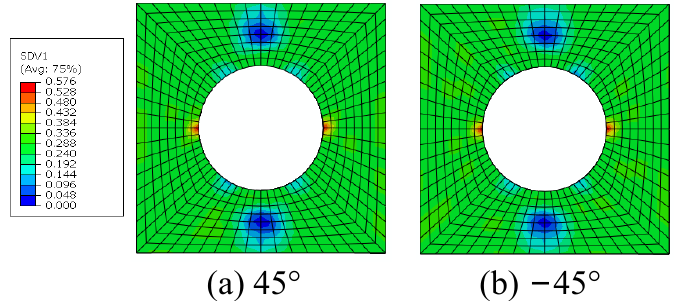
Figure 28. The initiations regions for matrix damage based on FFNN method.